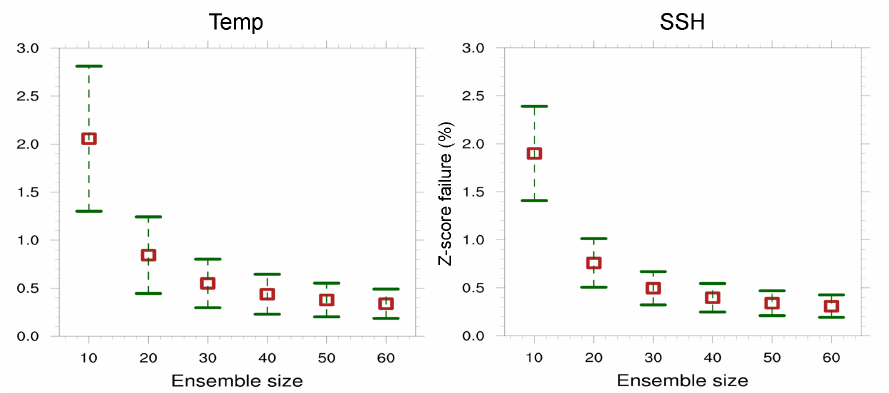
Figure 13. The distributions of experimental failure rates based on 1000 tests for the variables temperature (TEMP) and sea surface height (SSH). For each ensemble size, the green bars indicate the maximum and minimum values obtained, and the red boxes indicate the